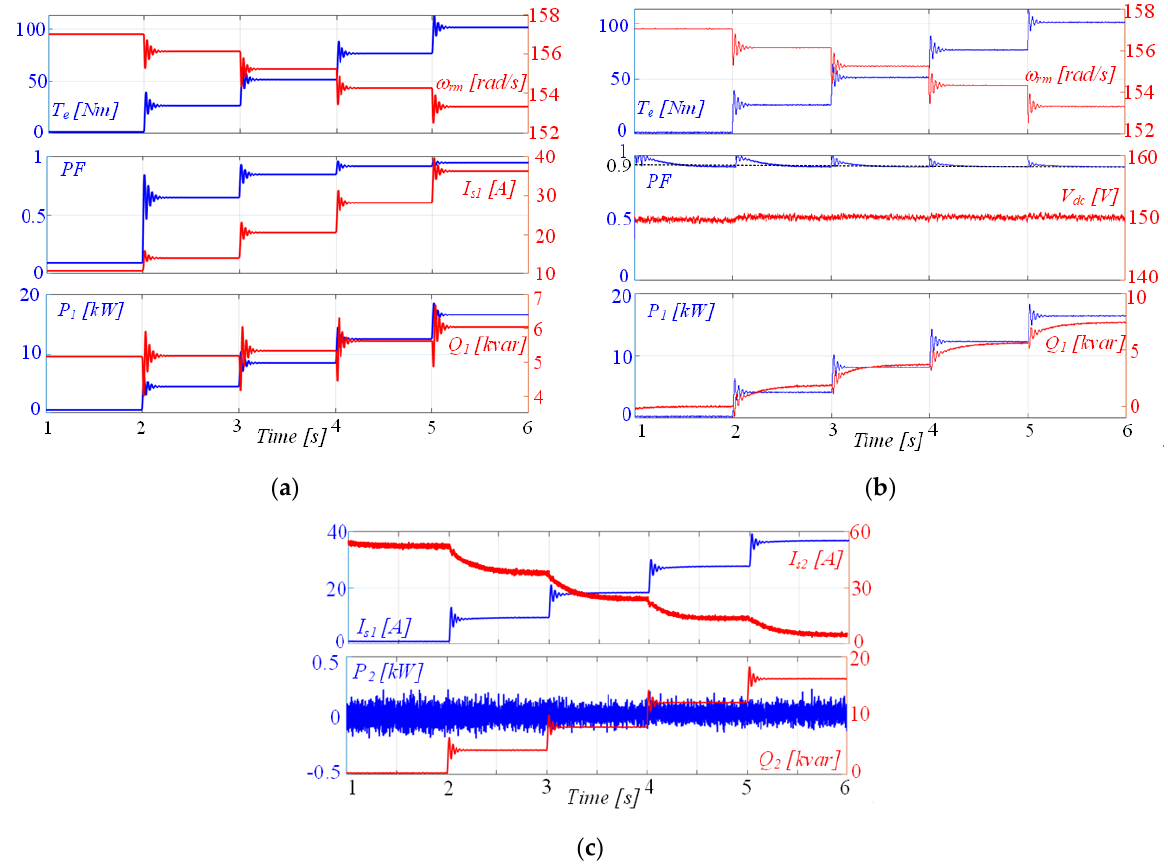
Figure 12. Dynamic transients under different torque load T L conditions: ( a ) in standard IM configuration and ( b , c ) in the proposed DWIM configuration.